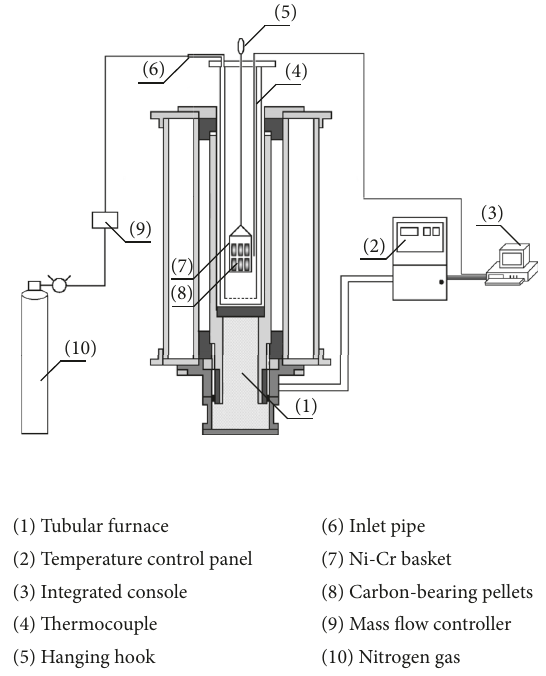
Figure 1: A schematic of experimental apparatus of reduction